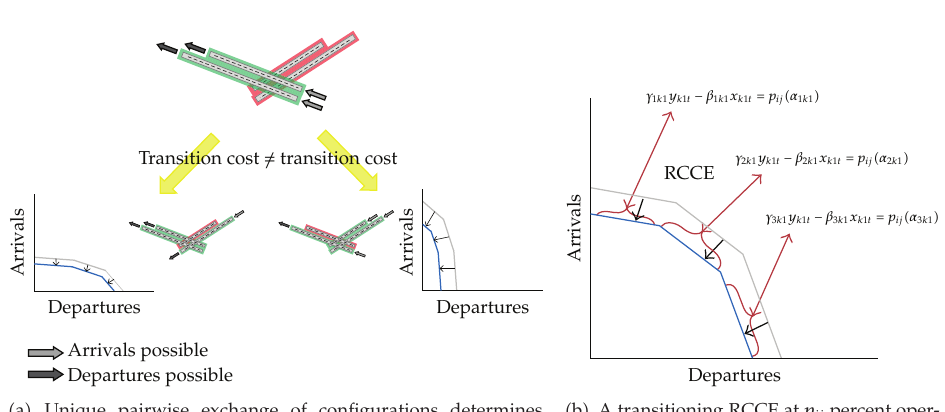
Figure 7: Fundamental principal of the MDTC